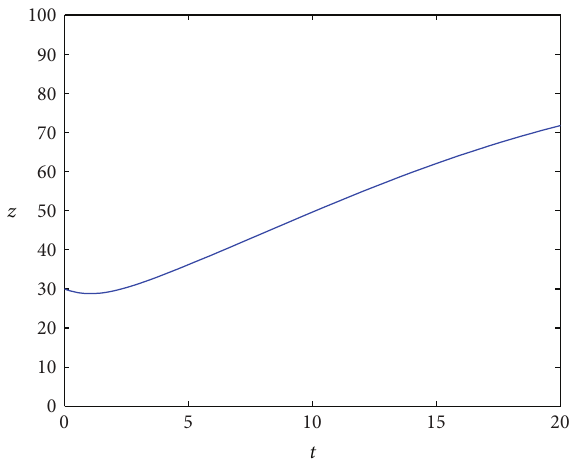
Figure 3: Plot of predator population 𝑧 versus time 𝑡